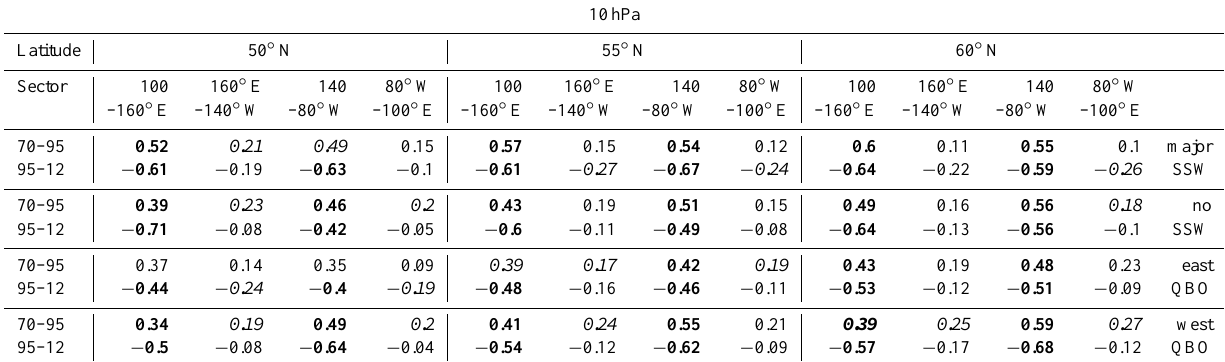
Table 3. At 10 hPa we can observe a positive difference (of 2– 5 m s − 1 ) between solar minimum and maximum for the west QBO in both sectors where cores occur. The differences are significant at the 95 % level. The differences are smaller and insignificant in the other two wind sectors. The east QBO does not reveal a systematic or significant difference. More- over, wind during solar maximum is sometimes stronger than during solar minimum. The differences between the QBO east and QBO west phase are negative during solar mini- mum (up to 3 m s − 1 ) in all studied sectors. These differences are, again, mainly significant in the two core sectors. Dif- ferences between the QBO east and QBO west phase during solar maximum are mainly positive but insignificant. The bottom panels show the same analysis as the top ones but for the v (meridional) wind component. The differences are smaller than for the total horizontal wind. We cannot find any specific features for all four groups. We can see only a few significant values in different